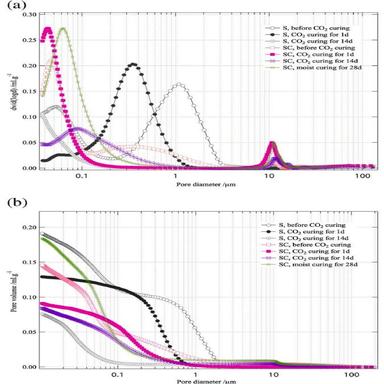
Pore size distribution of the SS pastes before and after carbonation curing: (a) derivative porosity curve (pore size distribution) and (b) cumulative porosity curve (paste S: 100 % SS; paste SC: 80 % SS + 20 % PC).